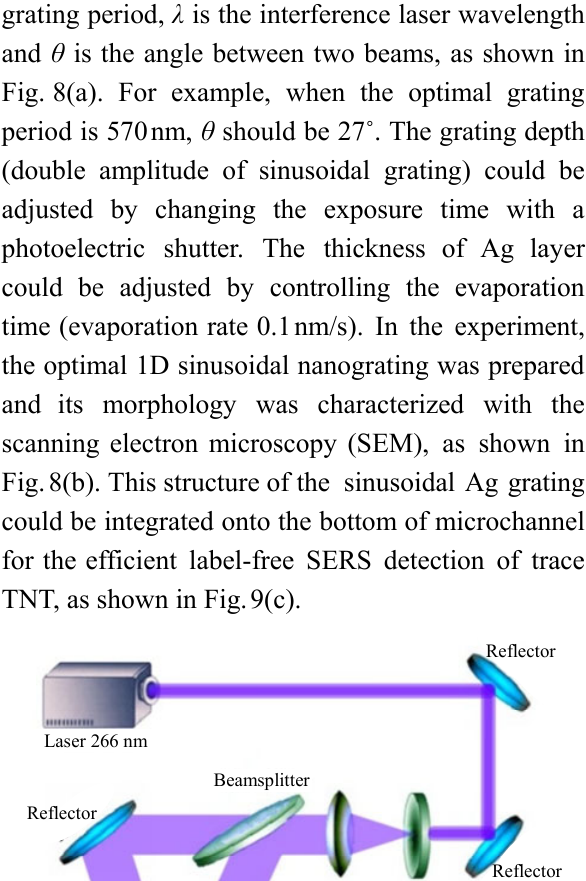
Fig. 7 Long-range SERS performance analysis of the 1D sinusoidal Ag nanograting: (a) electric field distribution of the xz section and (b) EF vs the distance size between the grating surface and the detected molecules.